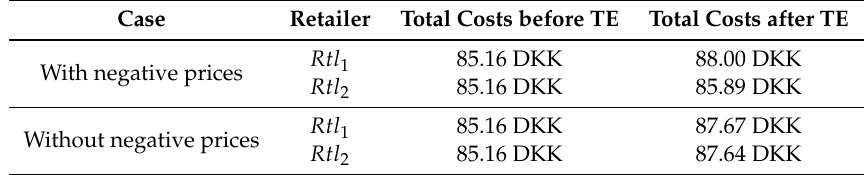
Table 1. Overview of total energy costs for EVs and HPs of two retailers. TE: transactive